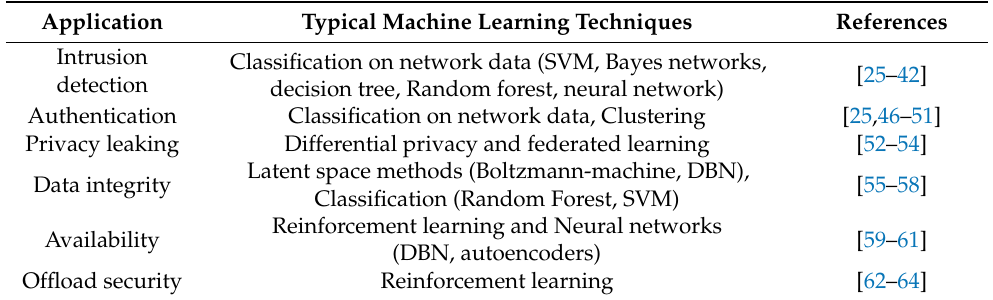
Table 1. Summary of applications of machine learning techniques in IIoT security and safety.